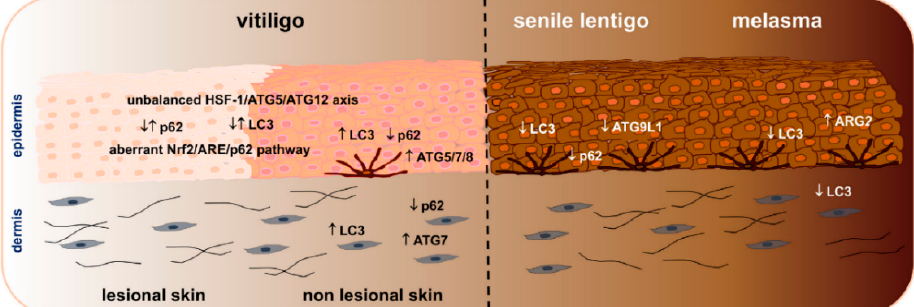
Figure 2. Autophagy dysregulation in hypo- and hyper-pigmented disorders: summary of autophagic markers known to be up- and/or down-modulated in epidermal and dermal compartments of lesional and non-lesional vitiligo, senile lentigo and melasma skin.